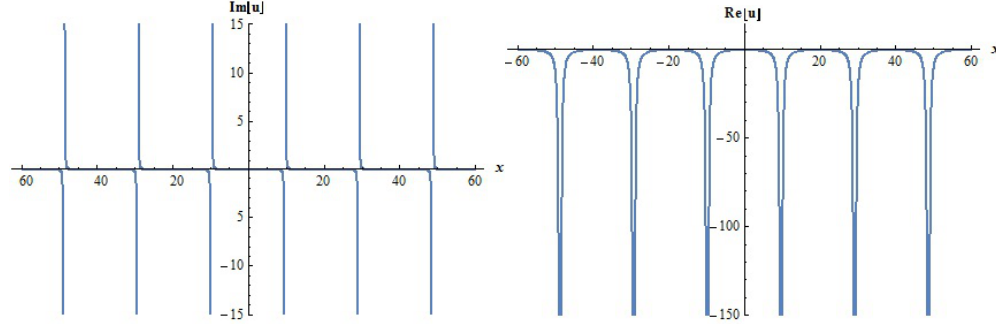
Figure 8. The 2D graphs of u 6 for α 2 = 0.1, α 3 = 0.32, ε = 1, w = 0.012, A 2 = 0.5, c = 0.01, t = 0.01, y =